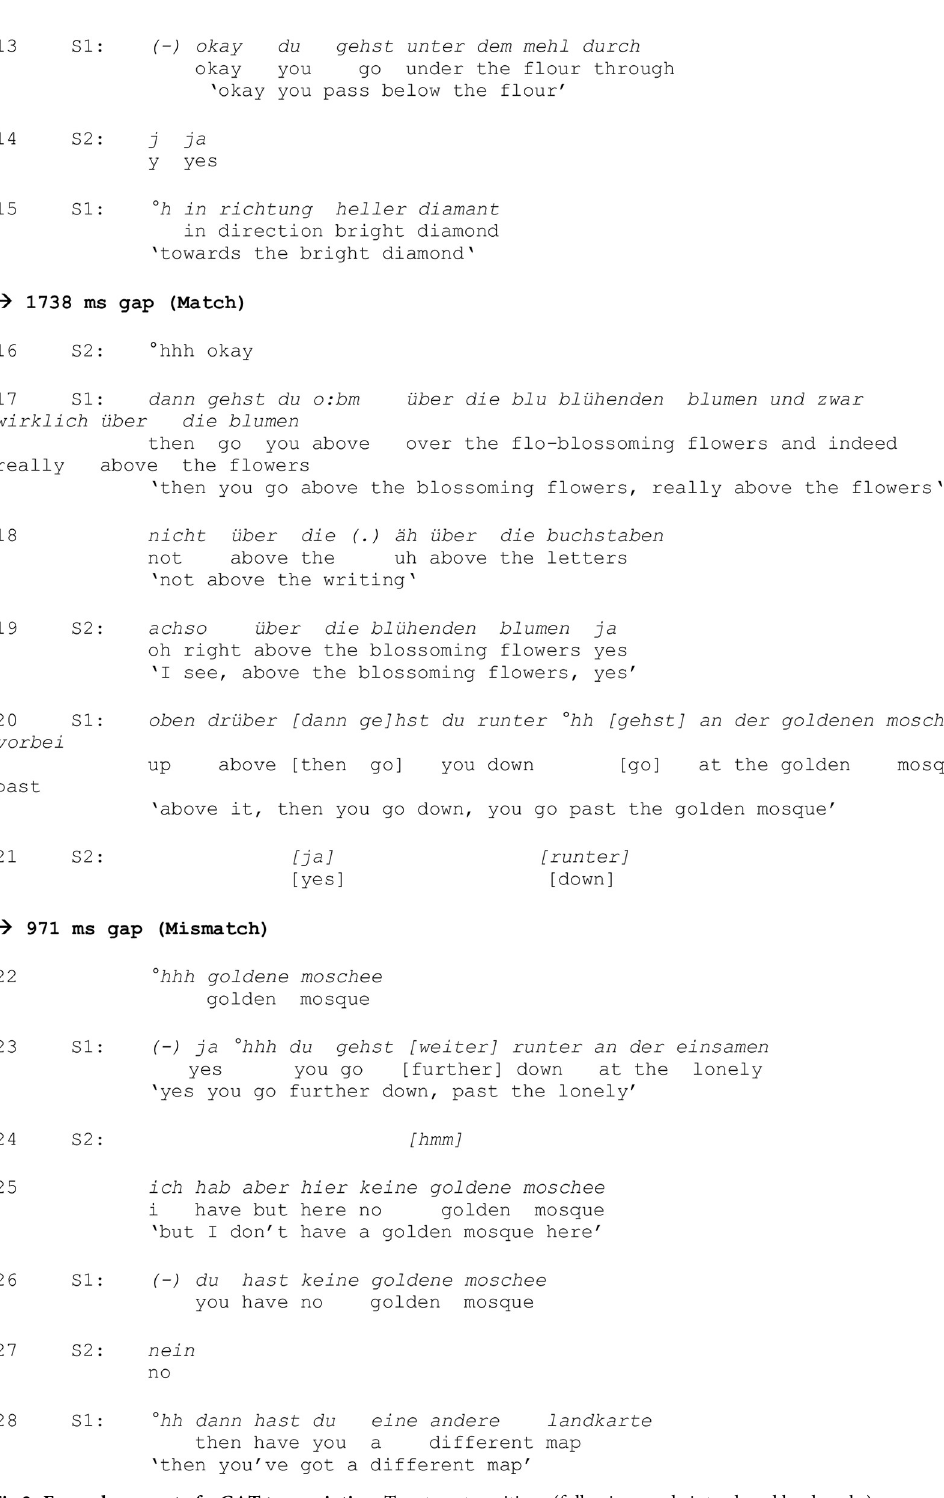
PLOS ONE | https://doi.org/10.1371/journal.pone.0284029 April 6, 2023 6 /